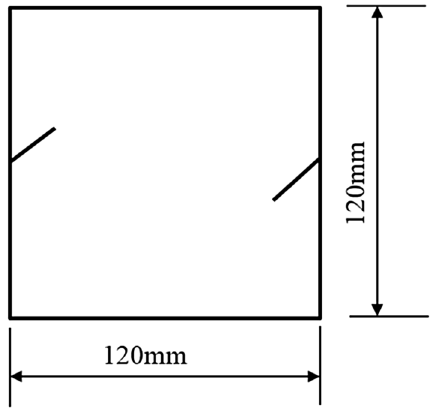
Figure 8. Precast crack orientation 5. Fissure length 2 cm, horizontal angle of fissure 40°.